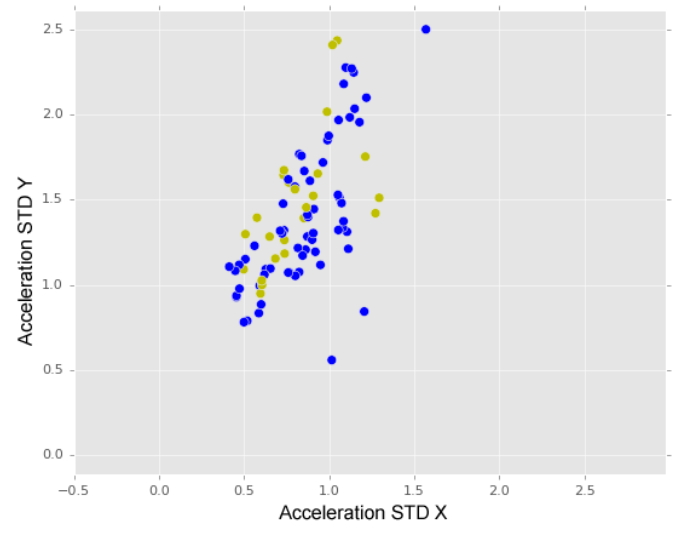
Figure 11. Long bumps (yellow dots) and short bumps (blue dots).